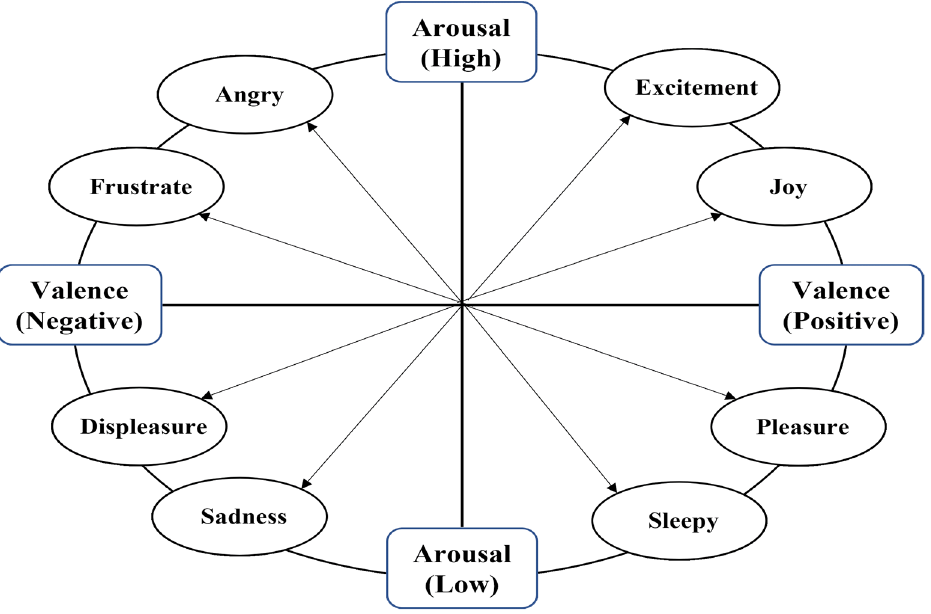
Figure 3. Dimensions model of emotions